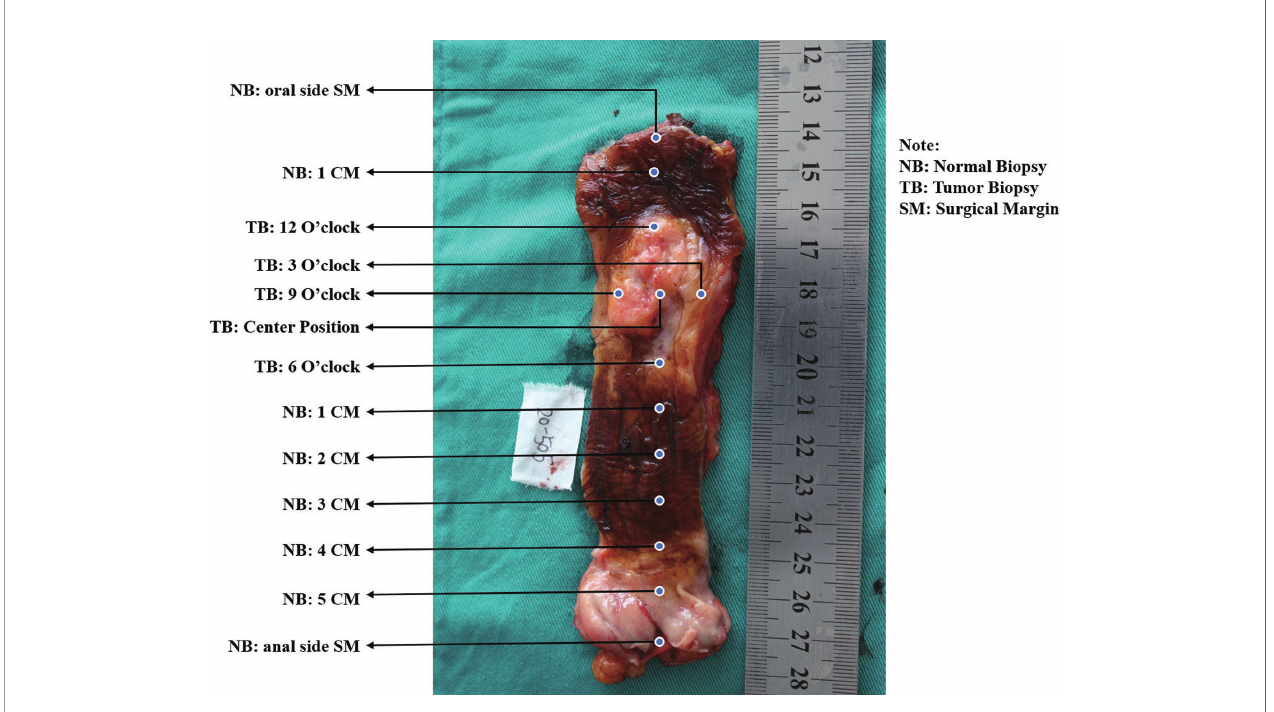
FIGURE 1 | Diagrammatic layout of systematic sampling